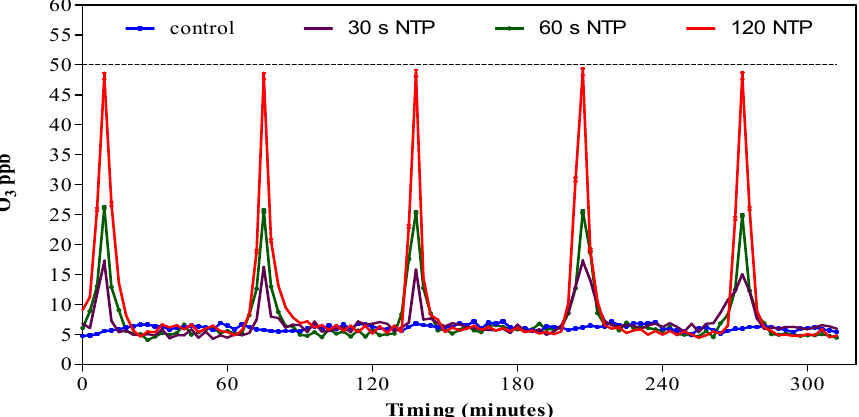
Figure 3. Time course (0–300 min) of ozone (O 3 ) concentration in air inside hydroponic growing system with nutrient solutions treated with NTP for 0 (control), 30, 60, or 120 s every hour, without plants grown in hydroponic tank (experiment 1). Each value is mean ( ± SE) of measurement taken in three different occasions over one day of system operation (Experiment 1). O 3 measurements were recorded every 3 min.